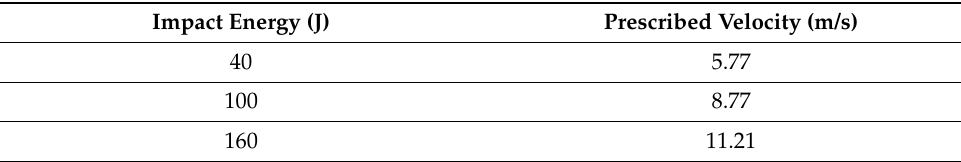
Table 8. Impact energy and the corresponding impactor’s initial velocity.